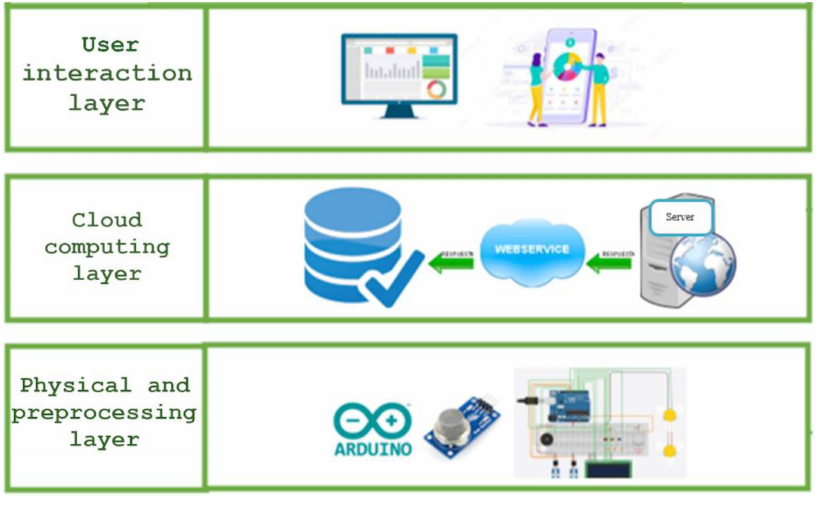
Figure 2. IdeAir system